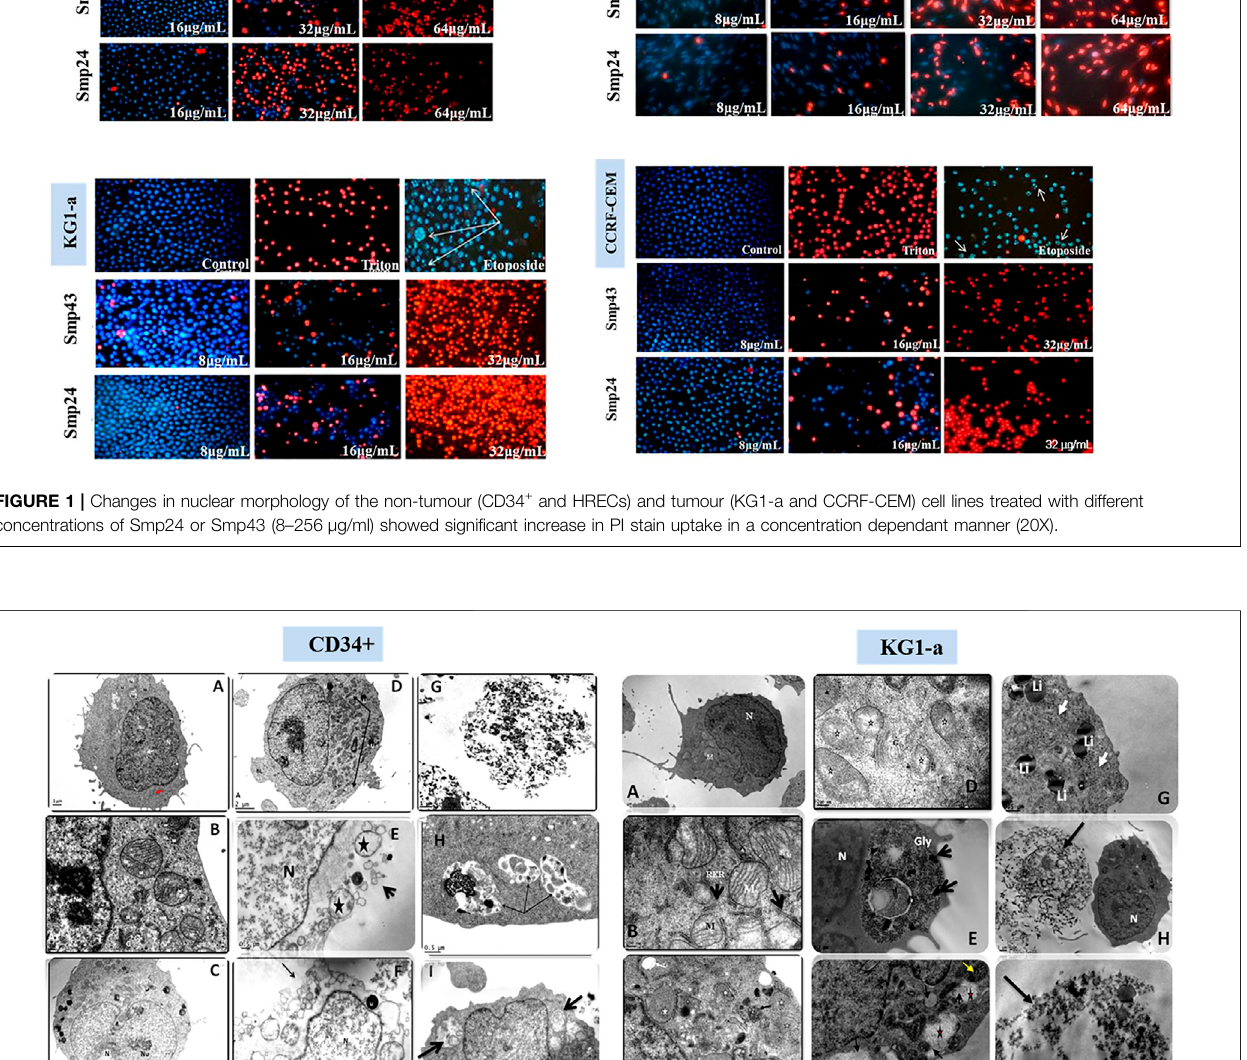
The attractiveness of AMPs in antimicrobial therapy lies in their mechanism of action as membrane disruptive agents, against which microbes have little natural resistance. AMPs